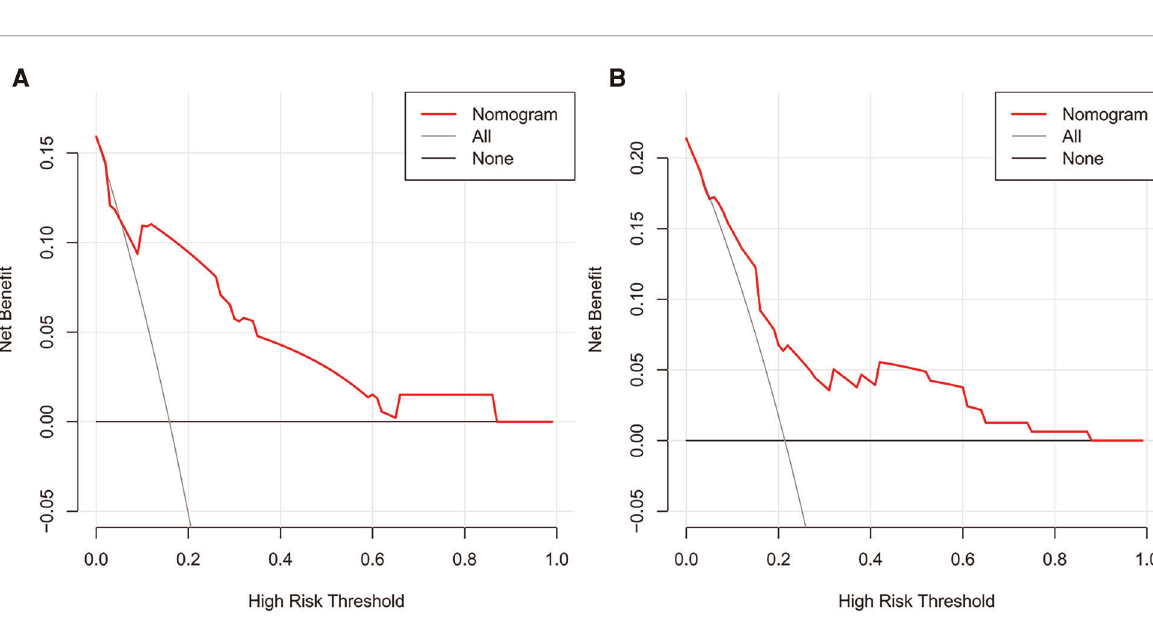
FIGURE 5 Decision curve analysis of the nomograms for left and right RLN LNM prediction. DCA plots revealed that the nomogram had good net bene fi ts in both left ( A ) and right ( B ) cohorts. RLN LNM, recurrent laryngeal nerve lymph node metastasis. DCA, decision curve